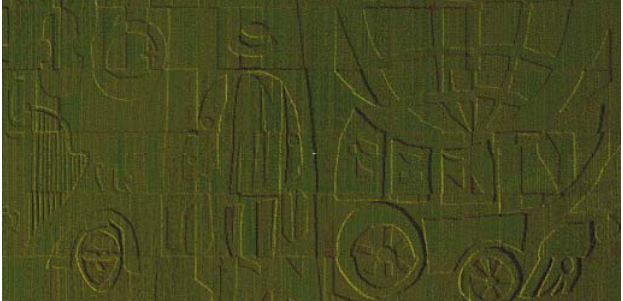
Figure 7. ‘Intensity Map’ Point Cloud of Poty Lazarotto art panel.